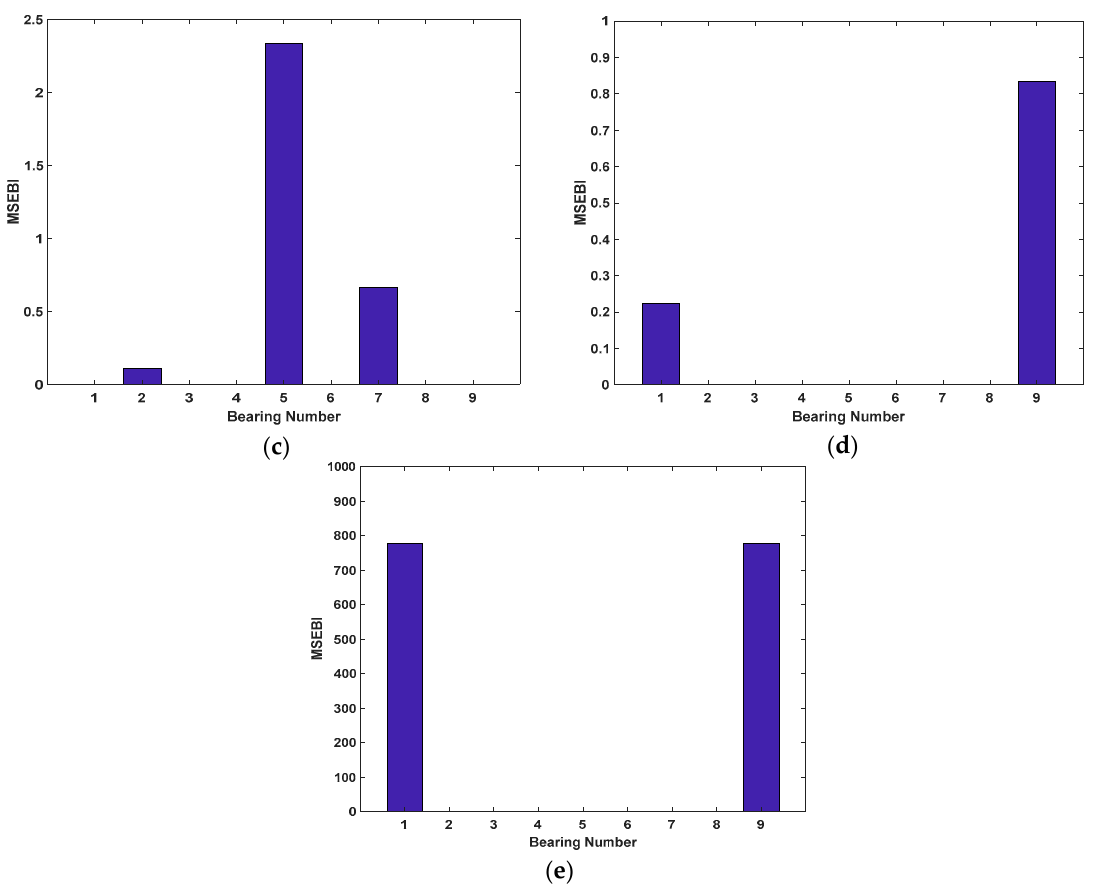
Figure 7. Results of structural bearings damage location: ( a ) Case 1; ( b ) Case 2; ( c ) Case 3; ( d ) Case 4; and ( e ) Case 5.